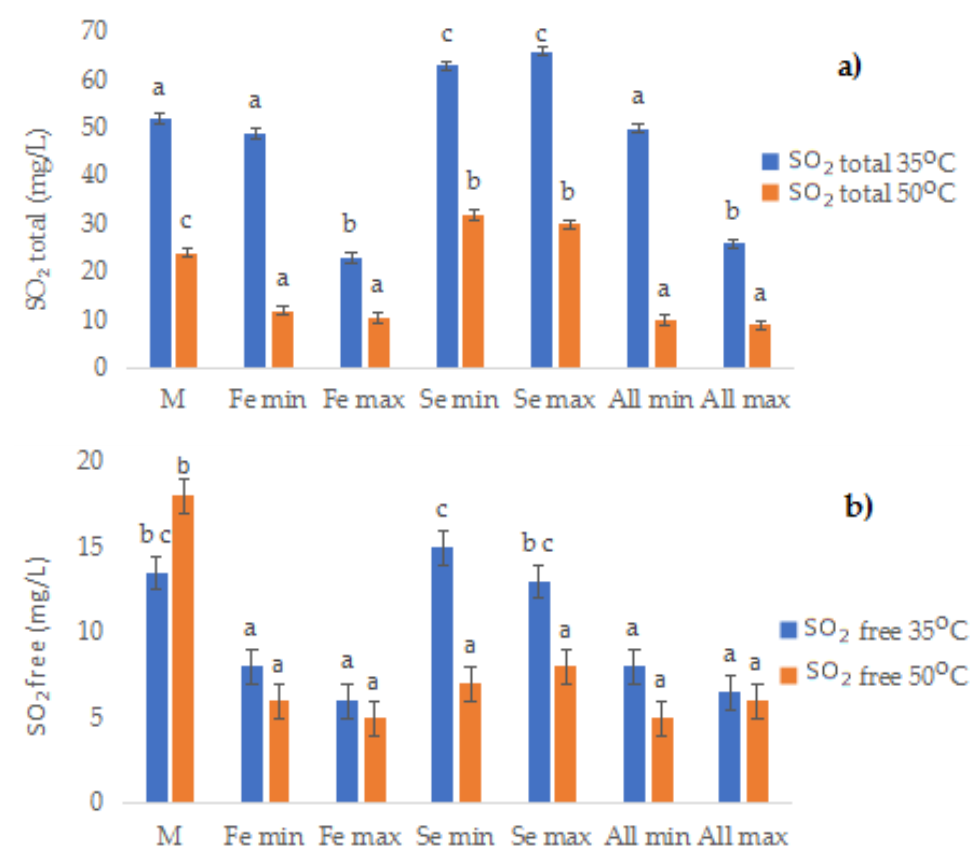
Figure 1. Total ( a ) and free ( b ) SO 2 content (mg/L) of the samples after 12 days of heating at 35 and 50 °C. Different letters at each temperature studied indicate statistically significant differences ( p < 0.05). Sample codes are described in Table 1.